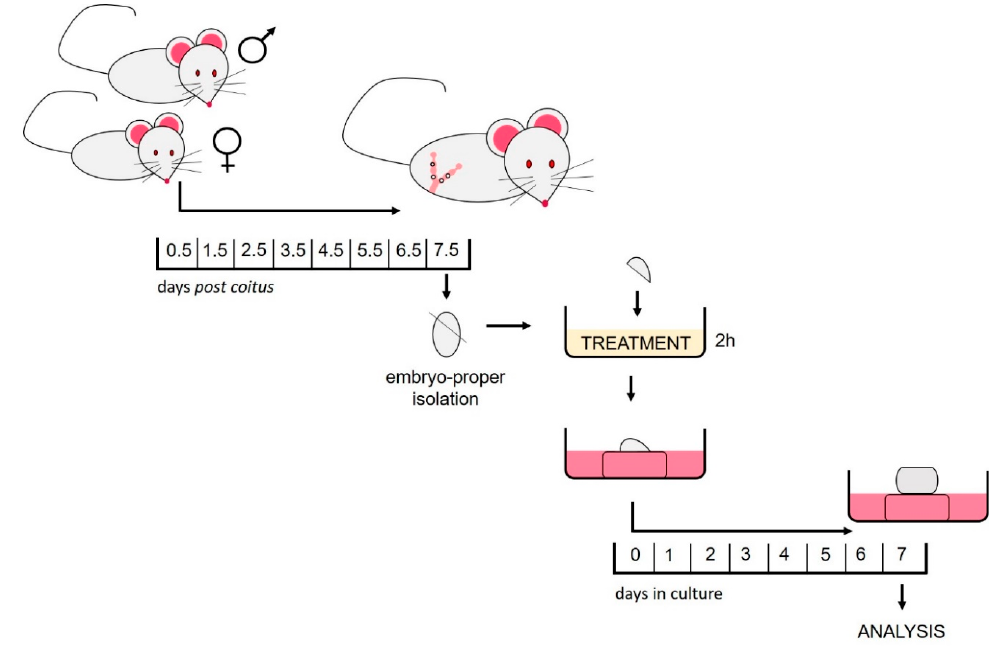
Figure 10. Depiction of the experimental design.